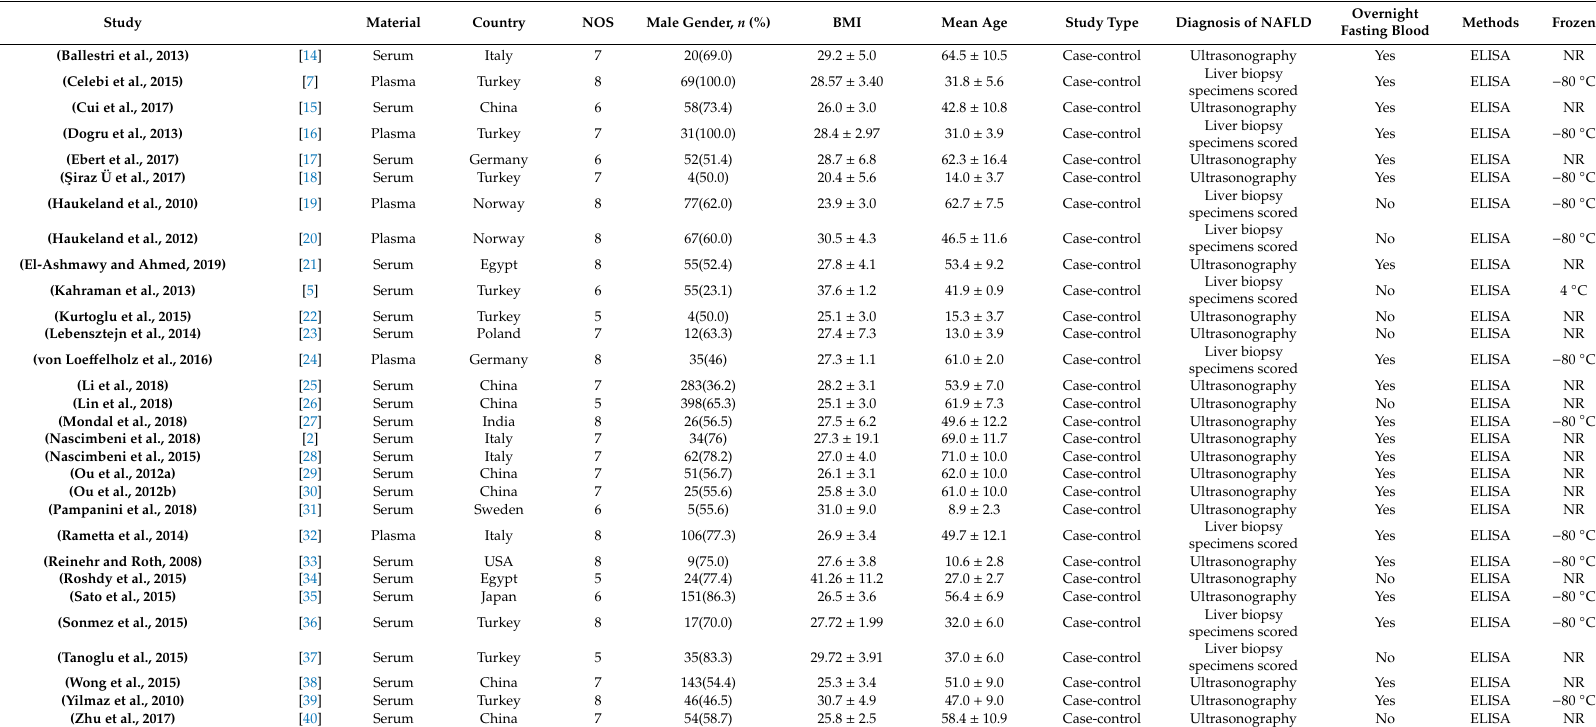
Table 1. Characteristics of the studies included for the meta-analysis of fetuin-A, fetuin-B, and NAFLD.